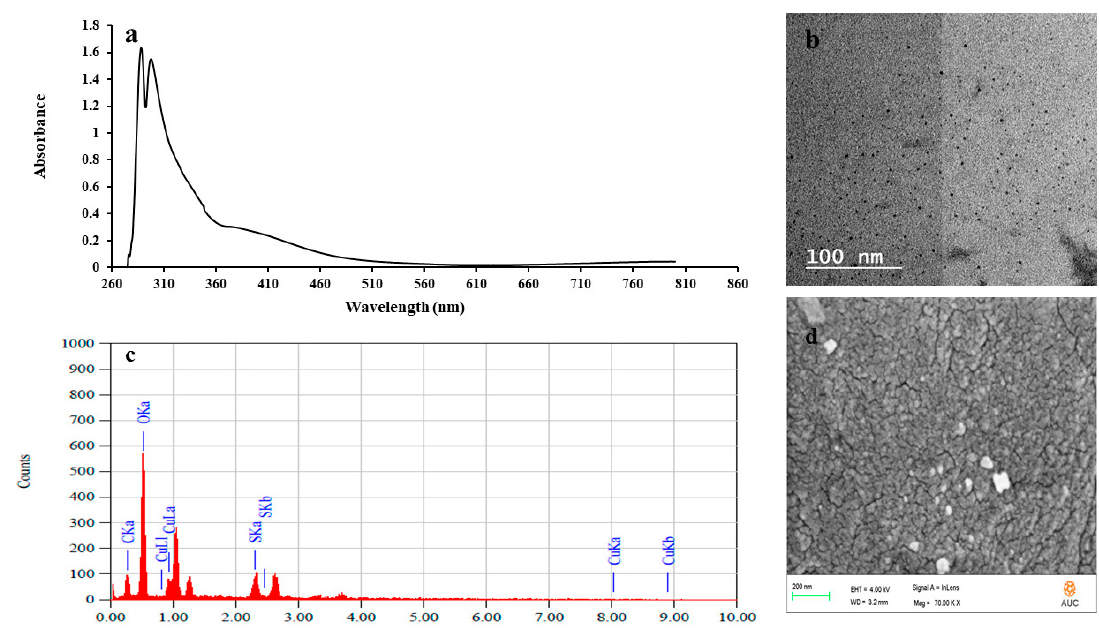
Figure 2. Characterization of sulfated polysaccharides (SPs) and Cu 2 O / Cu(OH) 2 nanoparticles (Cu NPs) using ultraviolet-visible (UV-Vis) spectroscopy ( a ), Transmission Electron Microscopy (TEM) imaging ( b ), Elemental-dispersive (EDX) spectroscopy analysis ( c ) and Scanning Electron Microscopy (SEM) imaging ( d ).